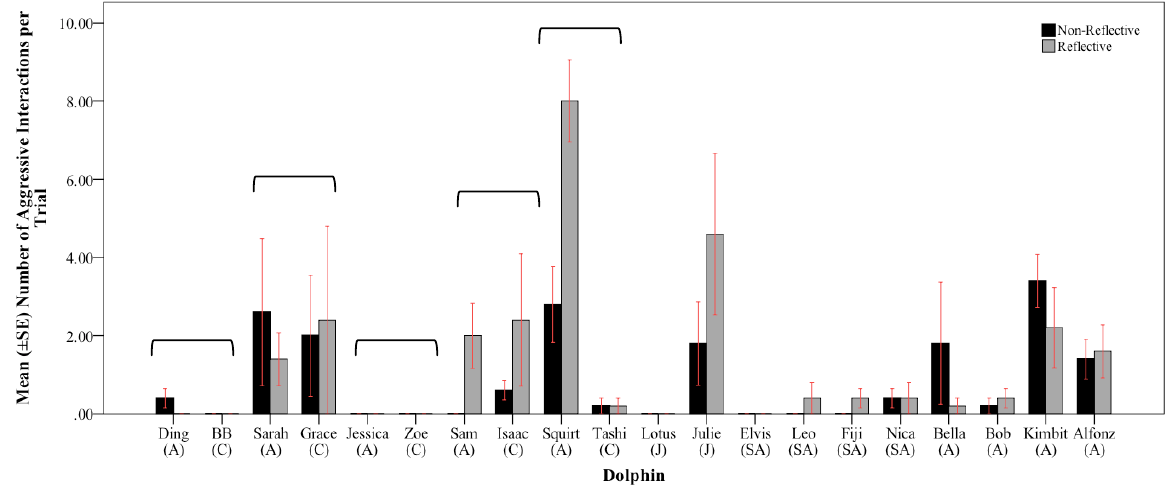
Figure 8. Mean (± 1 SE) number of aggressive interactions exhibited by each subject ( N = 30) in response to the reflective and non-reflective surfaces of the apparatus, identified as individuals and their age class: calf (C), juvenile (J), subadult (SA), and adult (A). Brackets delineate mother-calf